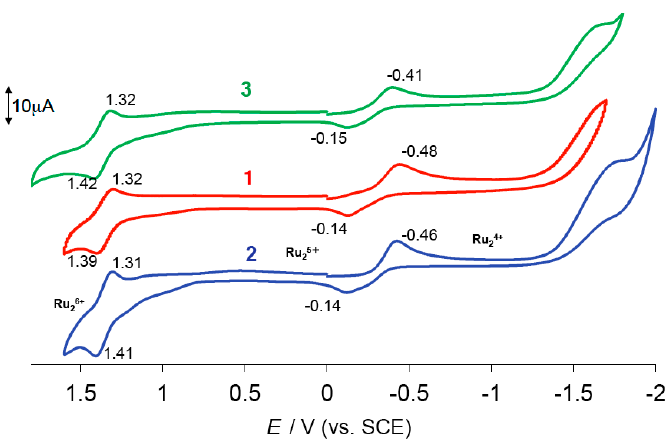
Figure 11. Cyclic voltammograms of 1 – 3 at 1.0 × 10 − 3 M in CH 2 Cl 2 containing 0.1 M TBA(BF) 4 (glassy carbon working electrode; scan rate = 50 mV/s).